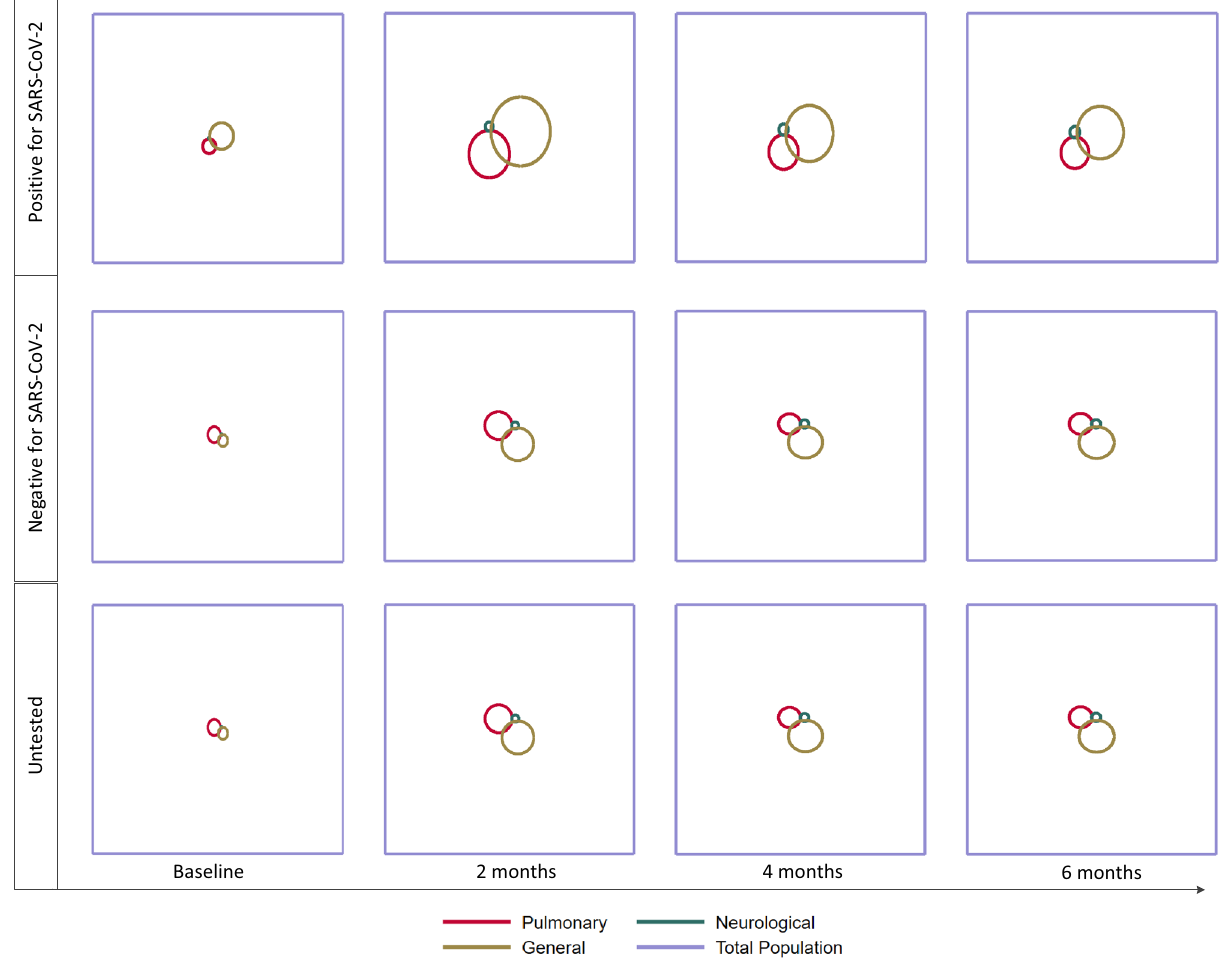
Figure 2. Proportions and intersections of complaints in the population in the group testing positive, the group testing negative and the untested group at baseline, 2, 4 and 6 months